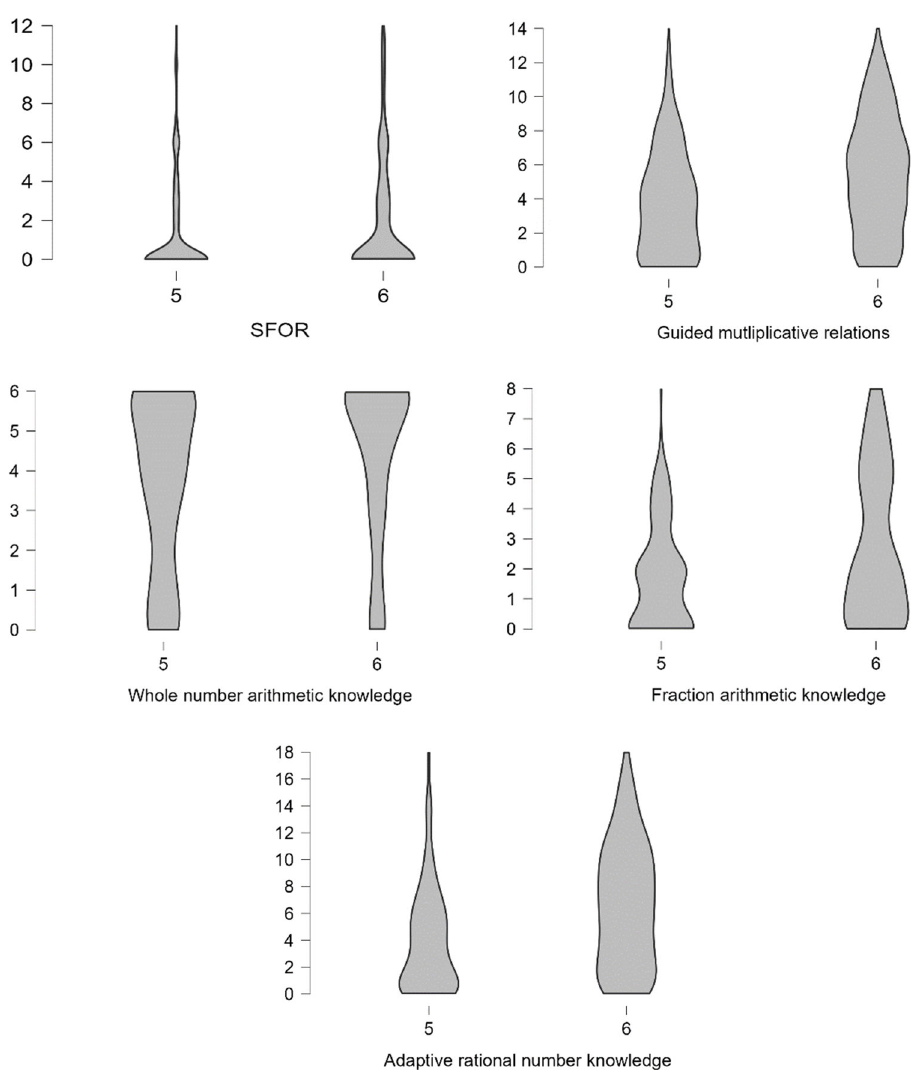
Violin Plots of Performance on the Mathematics Tasks Across the